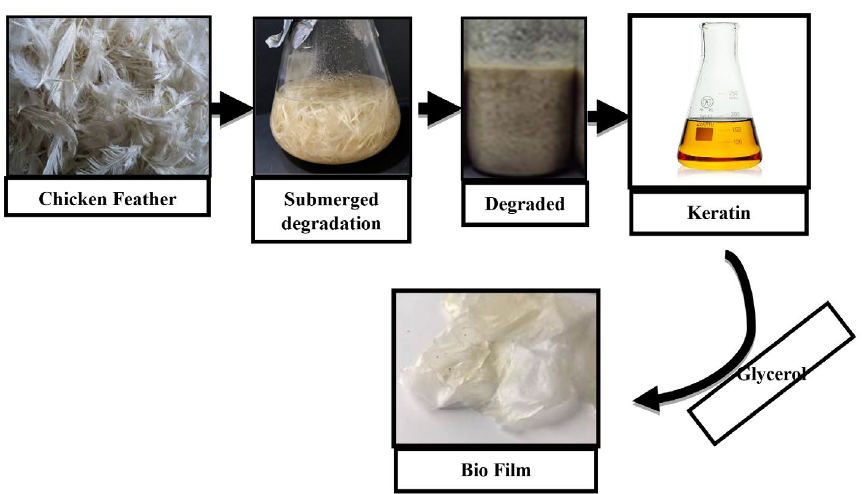
Fig. 6. Keratin-based bioplastic film derived from chicken